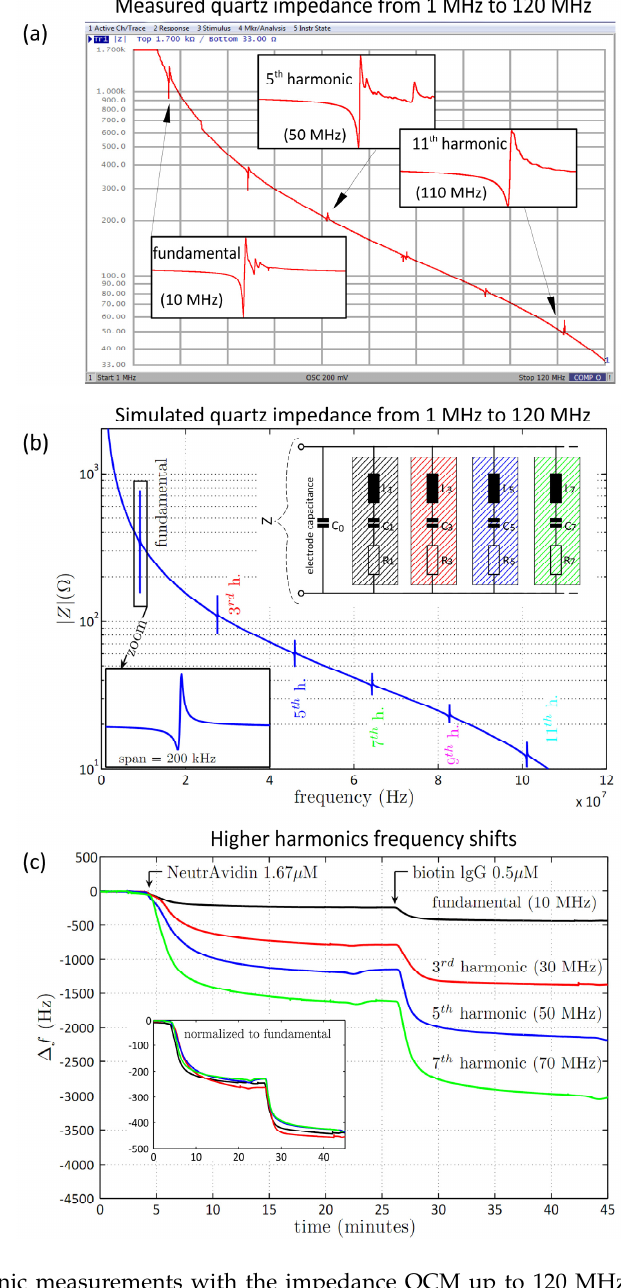
Figure 5. Harmonic measurements with the impedance QCM up to 120 MHz. ( a ) A broadband impedance sweep is done between 1 MHz and 120 MHz (1601 points). Based on the fundamental resonance frequency at 10 MHz, subsequent odd harmonic resonances are present up to 110 MHz corresponding to the 11th harmonics; ( b ) modeled impedance sweep using harmonic resonators. The individual resonances correspond to the multiple LCR circuits (sketches of LCR 1 , LCR 3 , LCR 5 , and LCR 7 as inset) with the overall slope of the impedance curve mainly defined by the electrode capacitance C 0 ; and ( c ) experimental results of the higher harmonics impedance QCM. The two step bio-chemical reaction (first step is NeutrAvidin adsorption to gold; second step is biotin-IgG binding to the avidin layer) is measured at the fundamental frequency and at higher harmonics (third, fifth, and seventh harmonics). For the harmonic frequencies, both the absolute frequency and the frequency shifts are multiple integer values of the corresponding fundamental values. The normalized frequency shifts are shown in the